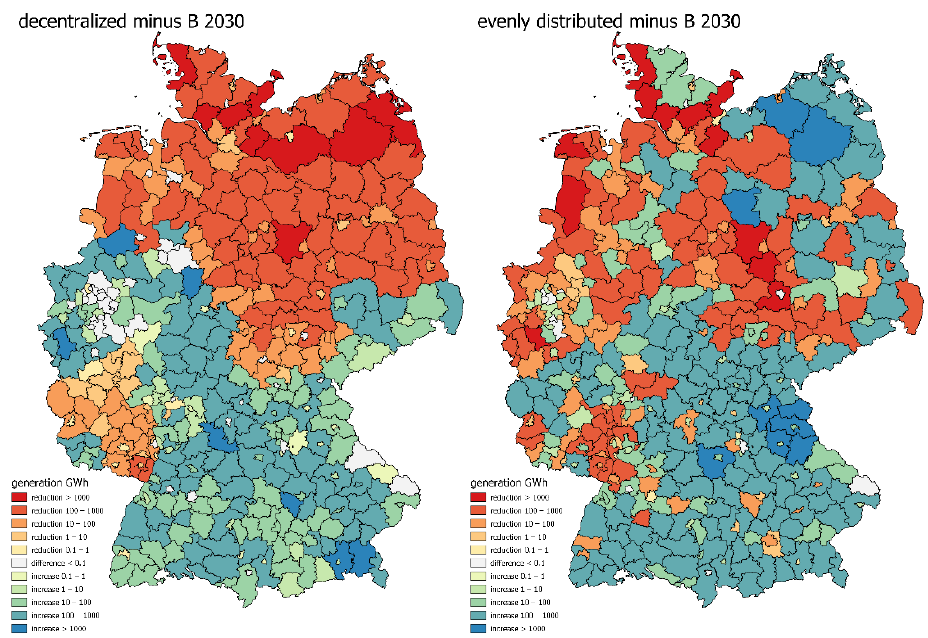
Figure 2. Change in annual wind electricity production in German districts in decentralized distribution ( left ) and in socio-ecologic distribution ( right ) in comparison to economic distribution [44]. A decentralized distribution of wind power plants leads to a reduction of electricity production in north-eastern districts and in Rhineland-Palatinate in western Germany of 45 TWh in total (orange and red districts in left map of Figure 2). Regions with high electricity demand incur a rise of 45 TWh of wind production, such as North Rhine-Westphalia, Hesse, Saxony, Bavaria and Baden-Wuerttemberg (green and blue districts in left map of Figure 2).